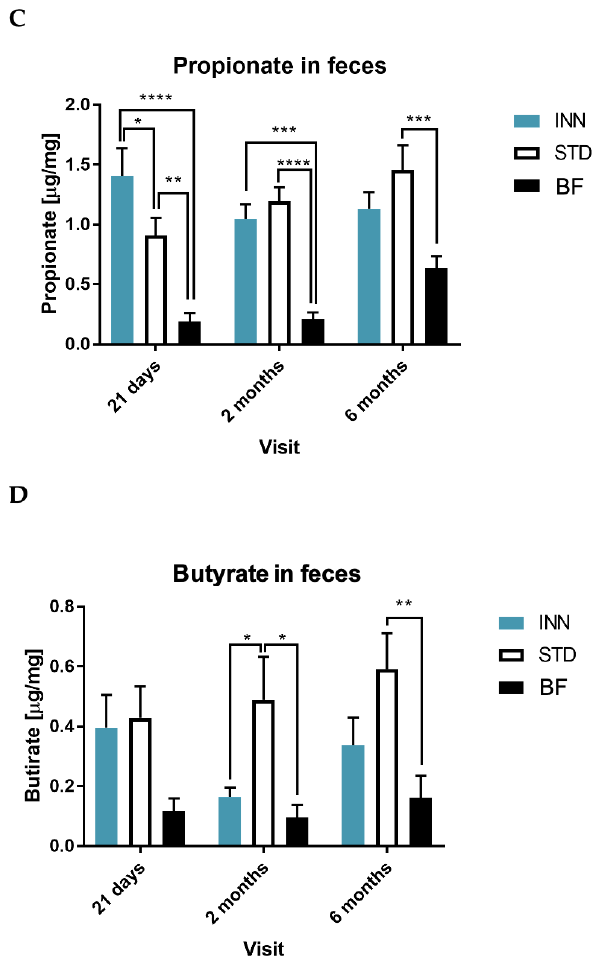
Figure 3. Lactate, acetate, propionate, and butyrate in feces, including INNOVA formula (INN), standard formula (STD), and breastfeeding (BF) at 21 days, 2 months, and 6 months. A. Lactate, B. Acetate, C. Propionate, D. Butyrate, * p < 0.05, ** p < 0.01, *** p < 0.001 and **** p <